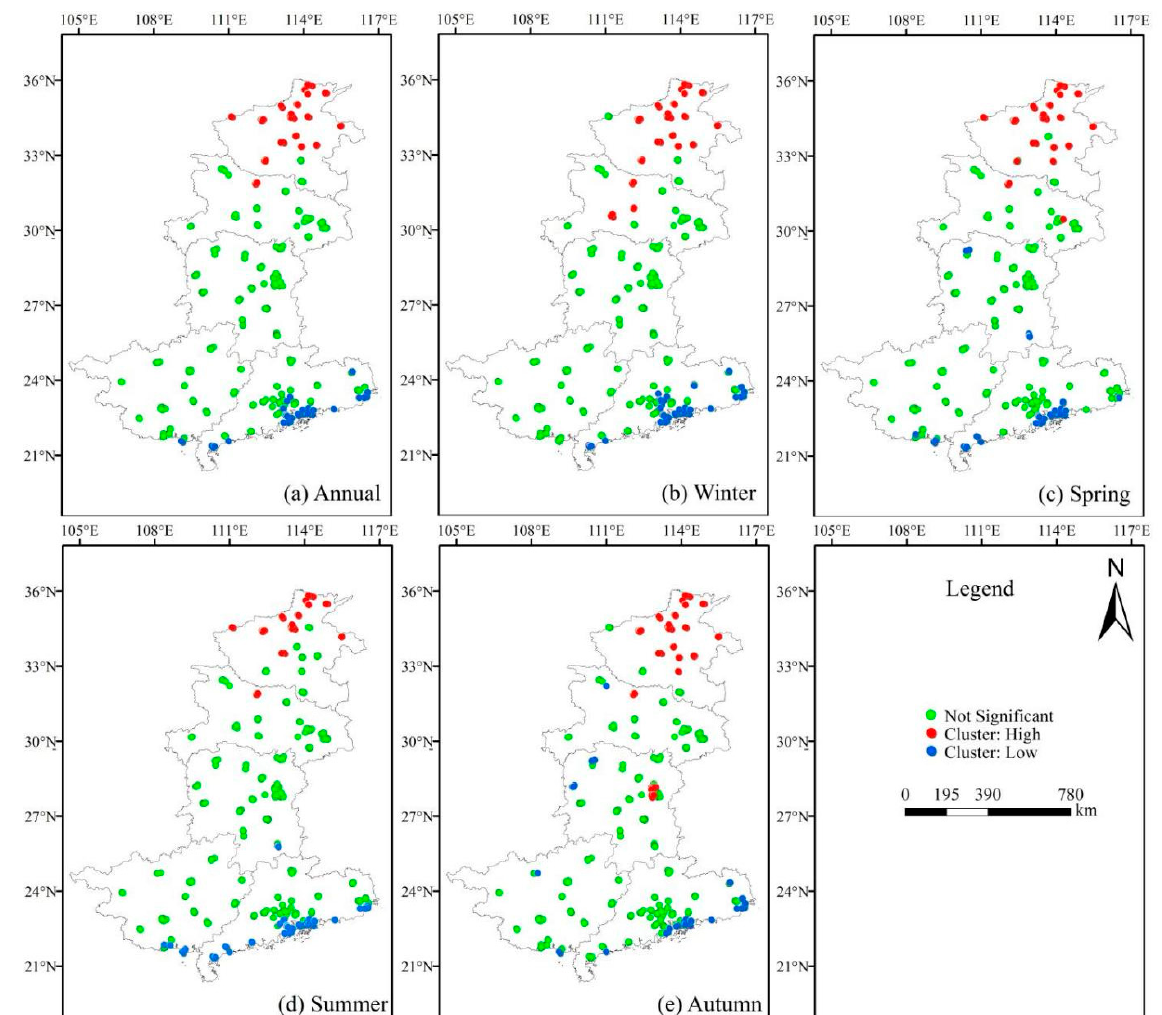
Figure 4. Clusters of PM 2.5 : ( a ) Annual, ( b ) Winter, ( c ) Spring, ( d ) Summer, ( e ) Autumn.